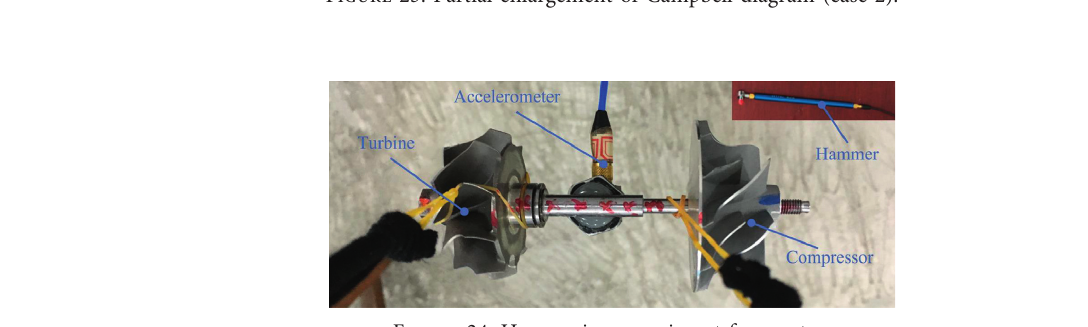
Figure 23: Partial enlargement of Campbell diagram (case 2).